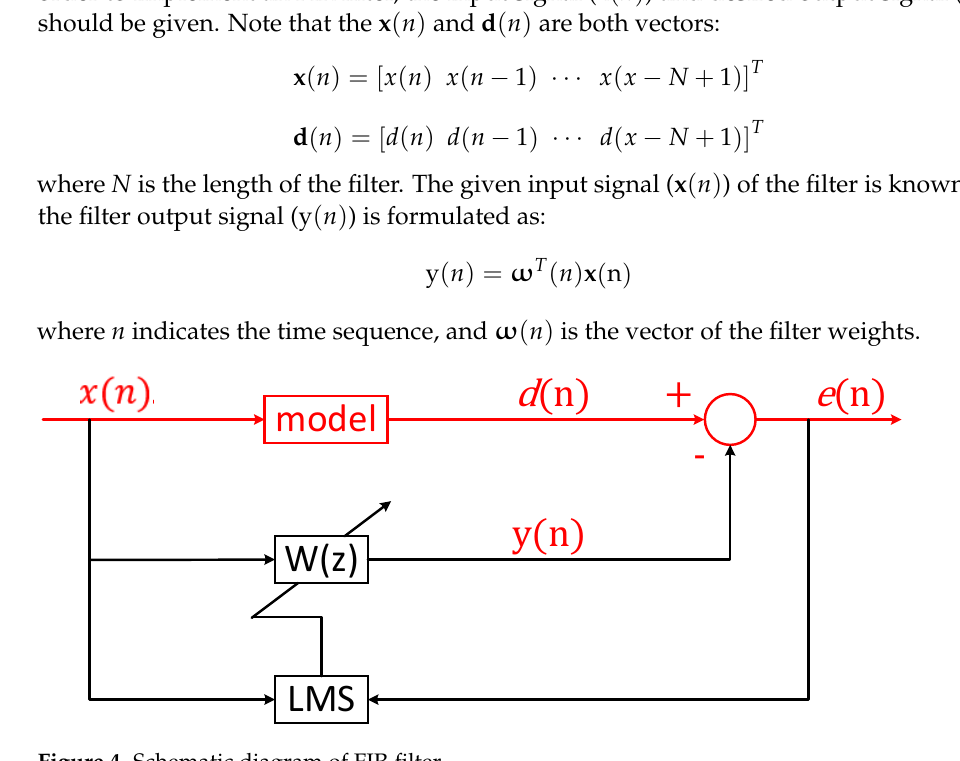
Figure 4. Schematic diagram of FIR